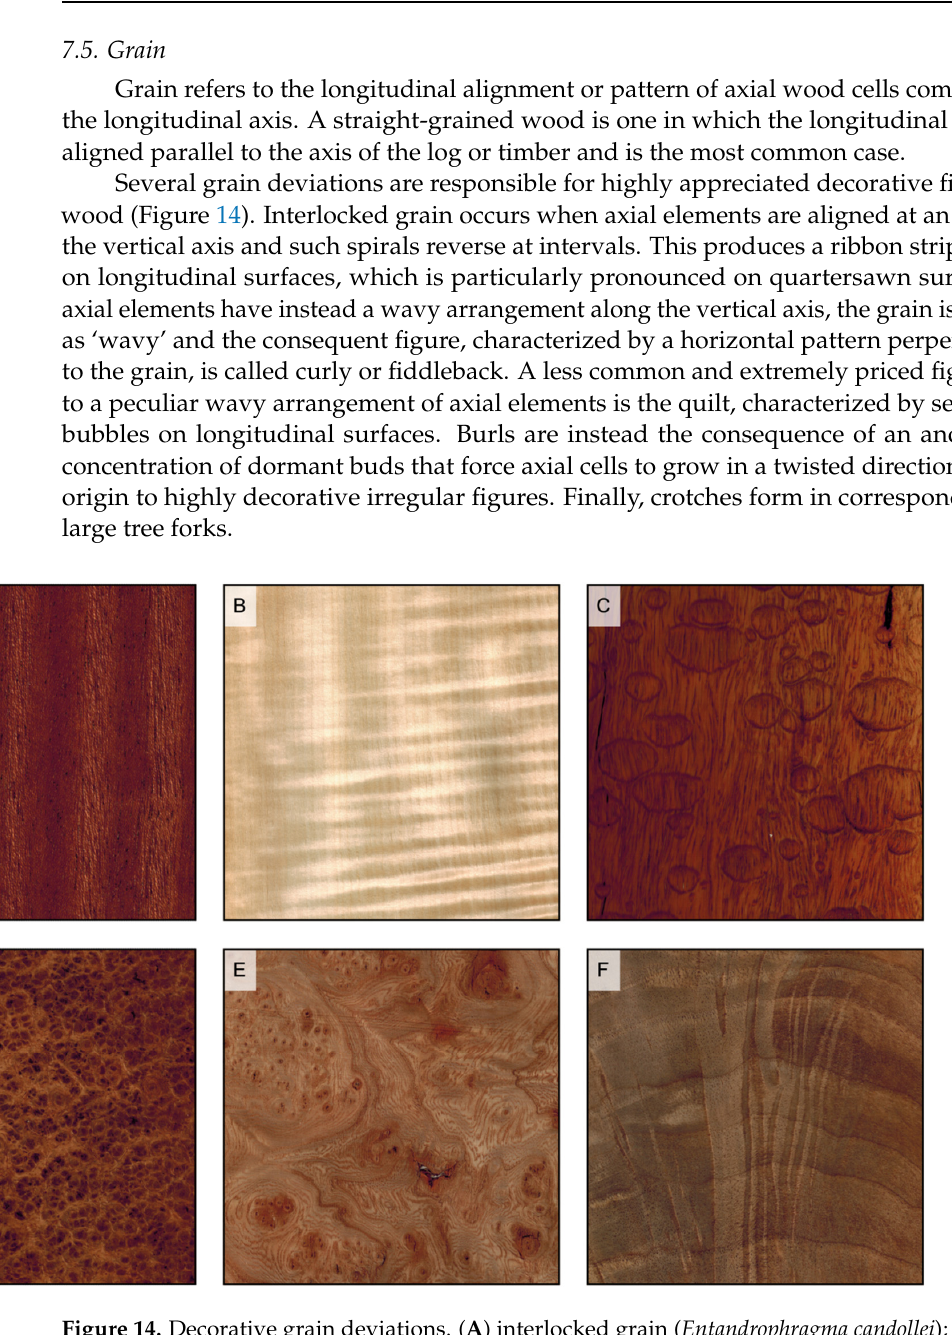
Figure 14. Decorative grain deviations. ( A ) interlocked grain ( Entandrophragma candollei ); ( B ) wavy grain ( Acer sp.); ( C ) quilt ( Pterocaprus sp.); ( D ) burl ( Pterocarpus indicus ); ( E ) burl ( Ulmus campestris ); ( F ) crotch ( Juglans regia ).